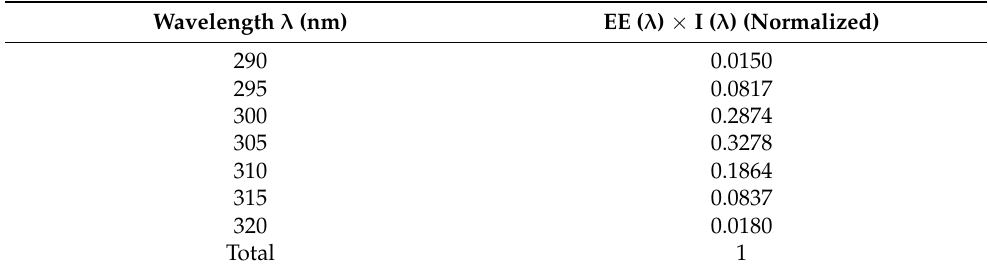
Table 1. Correlation between the erythemogenic effect (EE) and the radiation intensity at each wavelength (I)